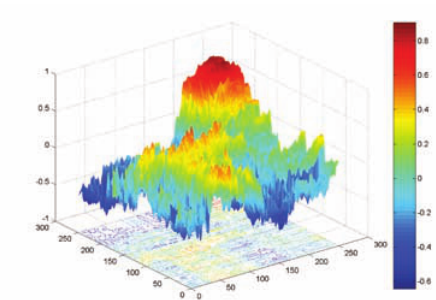
Fig. 2. Graphical view of the matrix of the interrelation of normalized covariance function of digital images for the lenses of eye with contact lenses